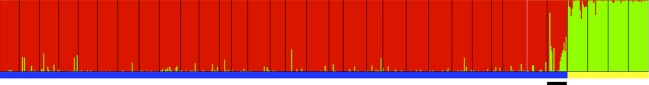
Assignment of individuals to two clusters (k = 2) by the program STRUCTURE. Accessions of noug are underlined in blue, whereas populations of noug's putative progenitor are underlined in yellow. The accession marked by a black bar is likely of hybrid origin.